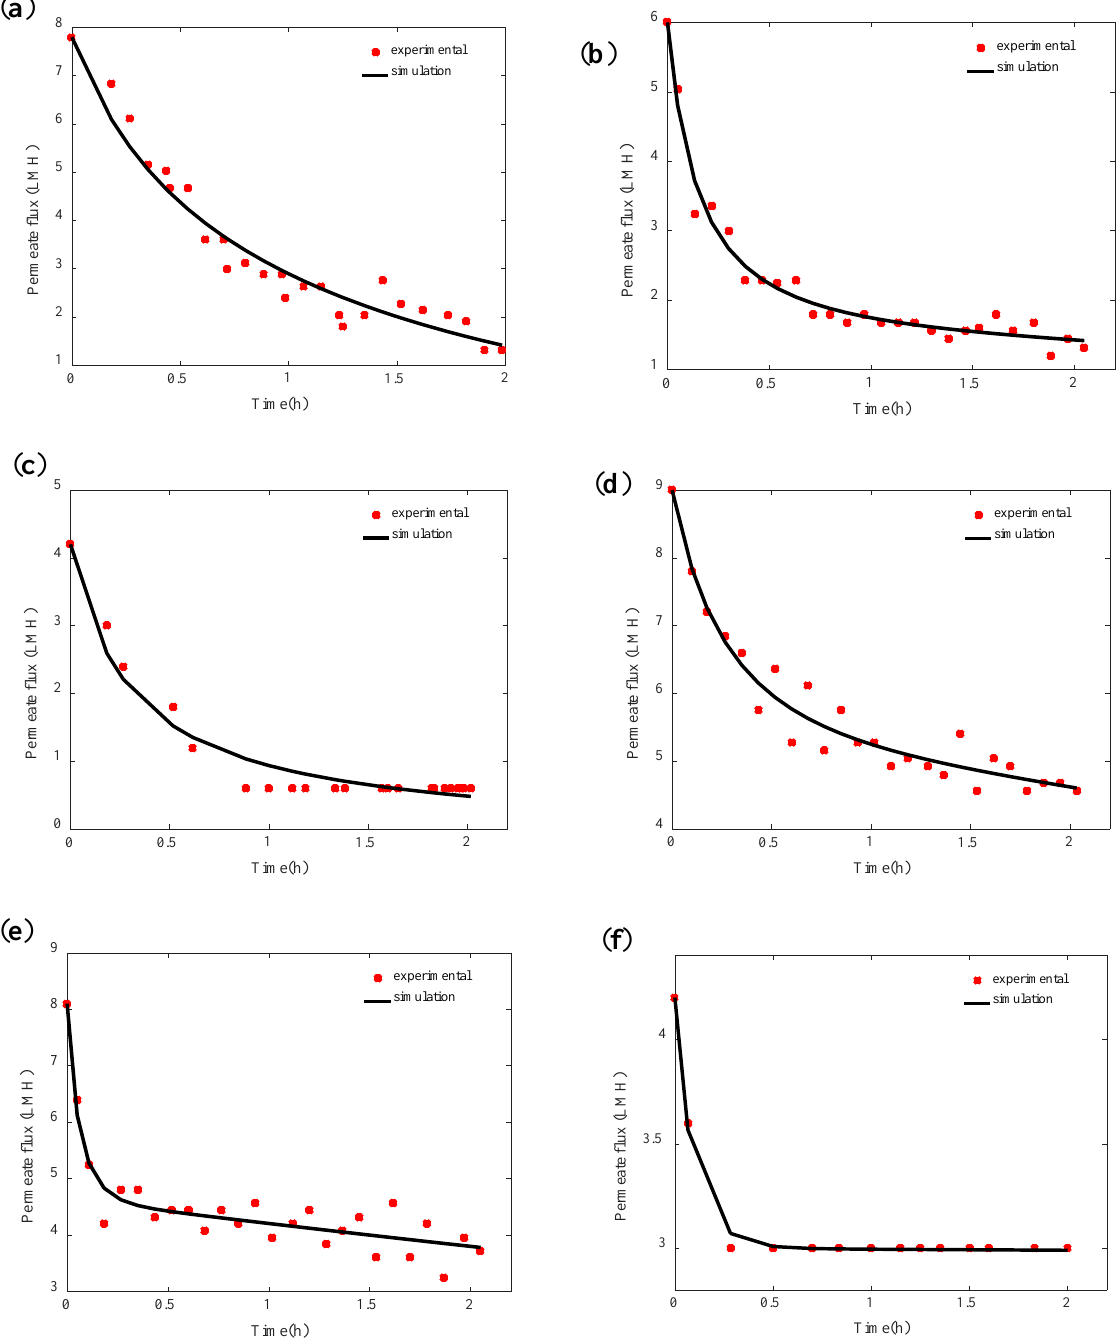
Figure 4. Comparison of the permeate flux experimental data and the model simulations obtained for different pH and temperatures ( a ) 35 °C, pH 4, ( b ) 35 °C, pH 6, ( c ) 35 °C, pH 8, ( d ) 50 °C, pH 4, ( e ) 50 °C, pH 6, and ( f ) 50 °C, pH 8. The model parameters were identified using the least-squares method detailed in Section 2.3. The values of least squares values obtained with the best fitting model are presented in Table 1. The model parameters’ values identified allowed the coefficient of determination R 2 and the correlation coefficient R to be maximized. The attachment ki- netic parameter k a showed higher values at higher feed temperatures. In fact, higher feed temperatures allowed higher convective forces created by higher vapor pressure differ-